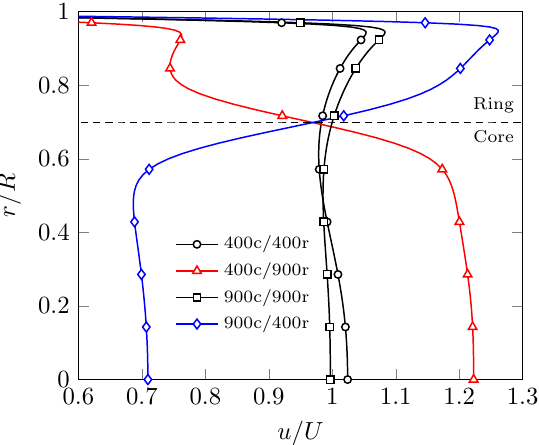
Figure 5. Velocity profile at the outlet of the catalytic zone. U is the area-weighted average